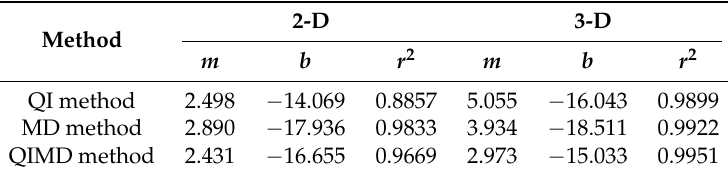
Table 2. CPU time ( t ) and the number of unknowns in 1-D ( N ) are associated using the best linear regression in the log-log scale by t = exp ( m ln N + b ) . Values of m , b and r 2 of the Quasi-Inverse (QI), Matrix Diagonalization(MD) and Quasi-Inverse Matrix Diagonalization (QIMD) methods in solving 2-D and 3-D Poisson equations are presented where r 2 here is the r -squared value of the best linear